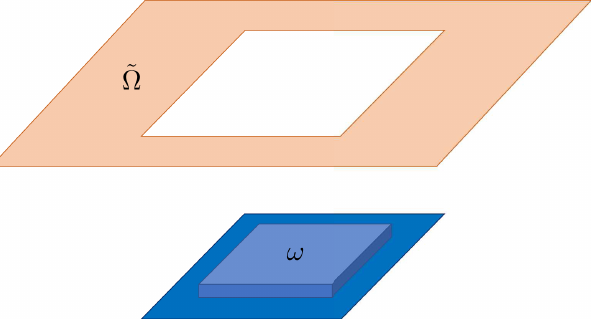
Fig. 3. Patch ω and the remaining structure ˜Ω .